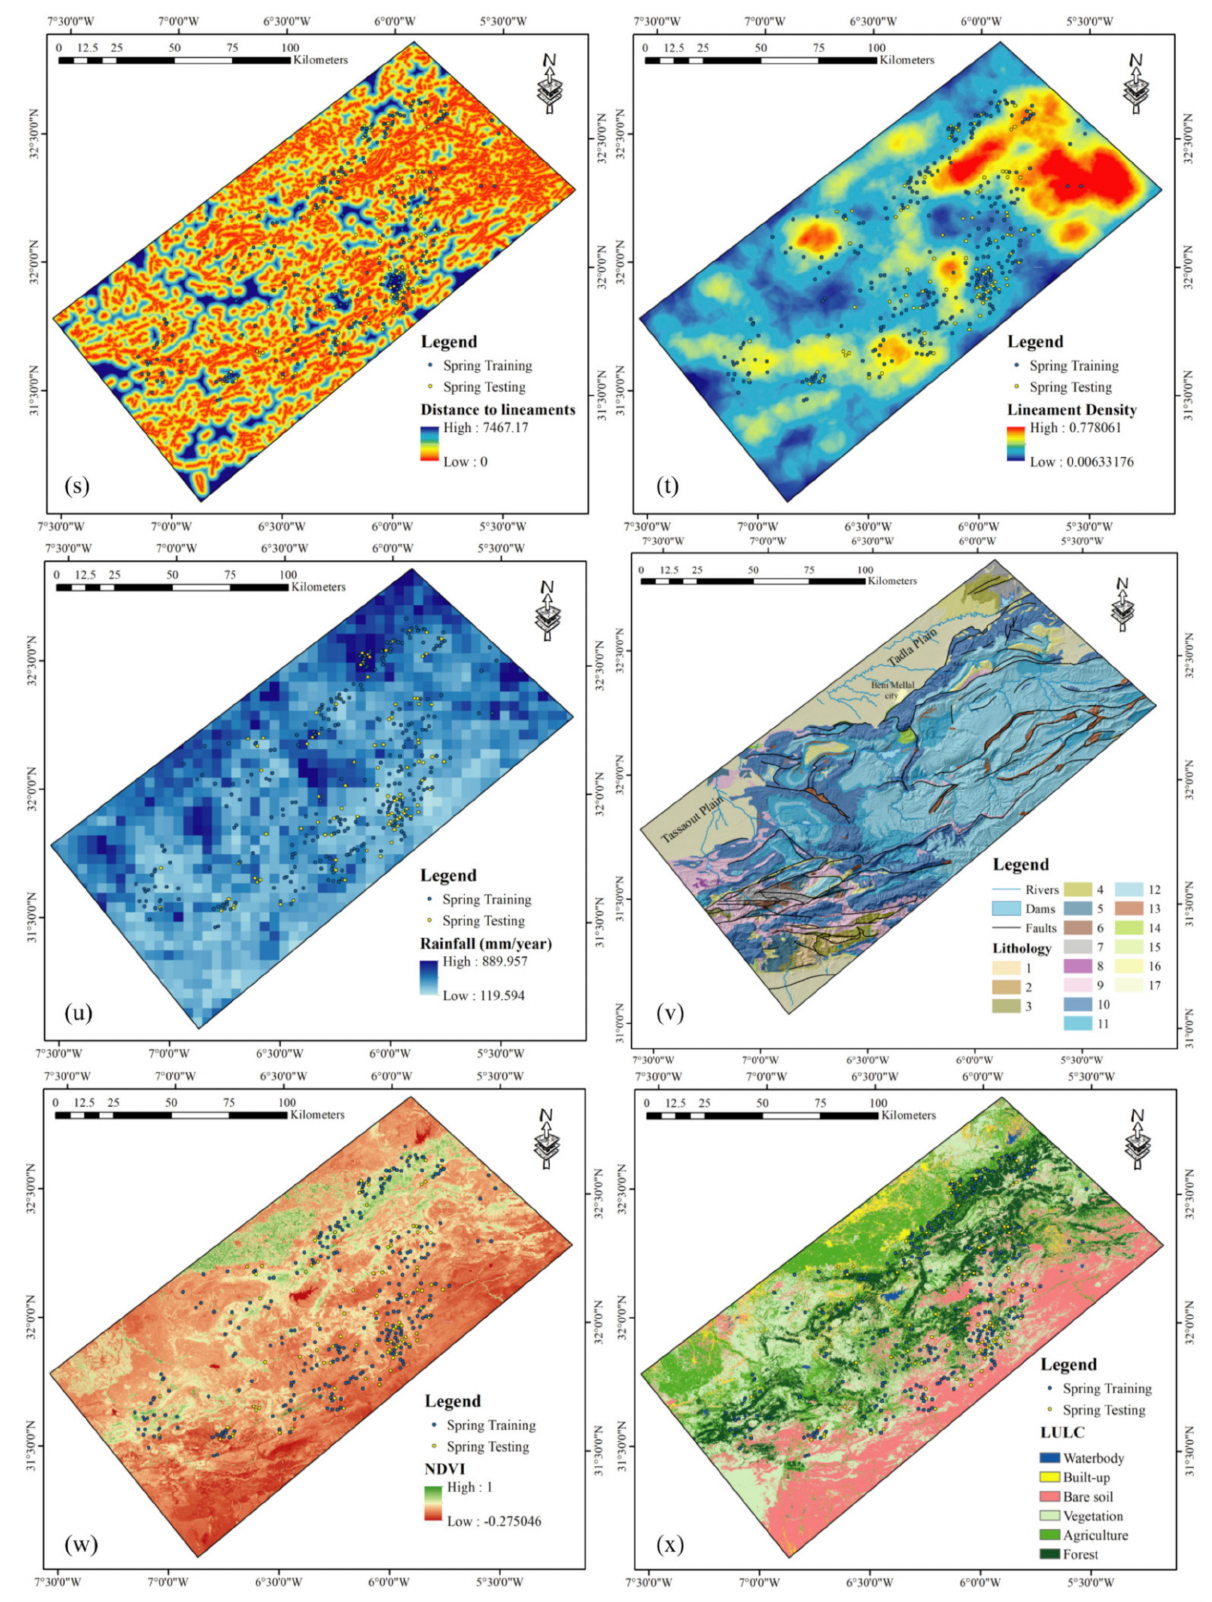
Figure 5. Groundwater influencing factors considered in the present study. ( a ) Elevation, ( b ) Aspect, ( c ) Slope, ( d ) Curvature, ( e ) Profile Curvature, ( f ) Plane Curvature, ( g ) Convergence, ( h ) TWI, ( i ) SPI, ( g ) TRI, ( k ) MeRugNu, ( l ) MRRTF, ( m ) MRVBF, ( n ) Distance to Rivers, ( o ) Density of Rivers, ( p ) LS, ( q ) Distance to Faults, ( r ) Density of Faults, ( s ) Distance to lineament, ( t ) Density of lineament, ( u ) Rainfall, ( v ) Lithology, ( w ) NDVI, ( x )